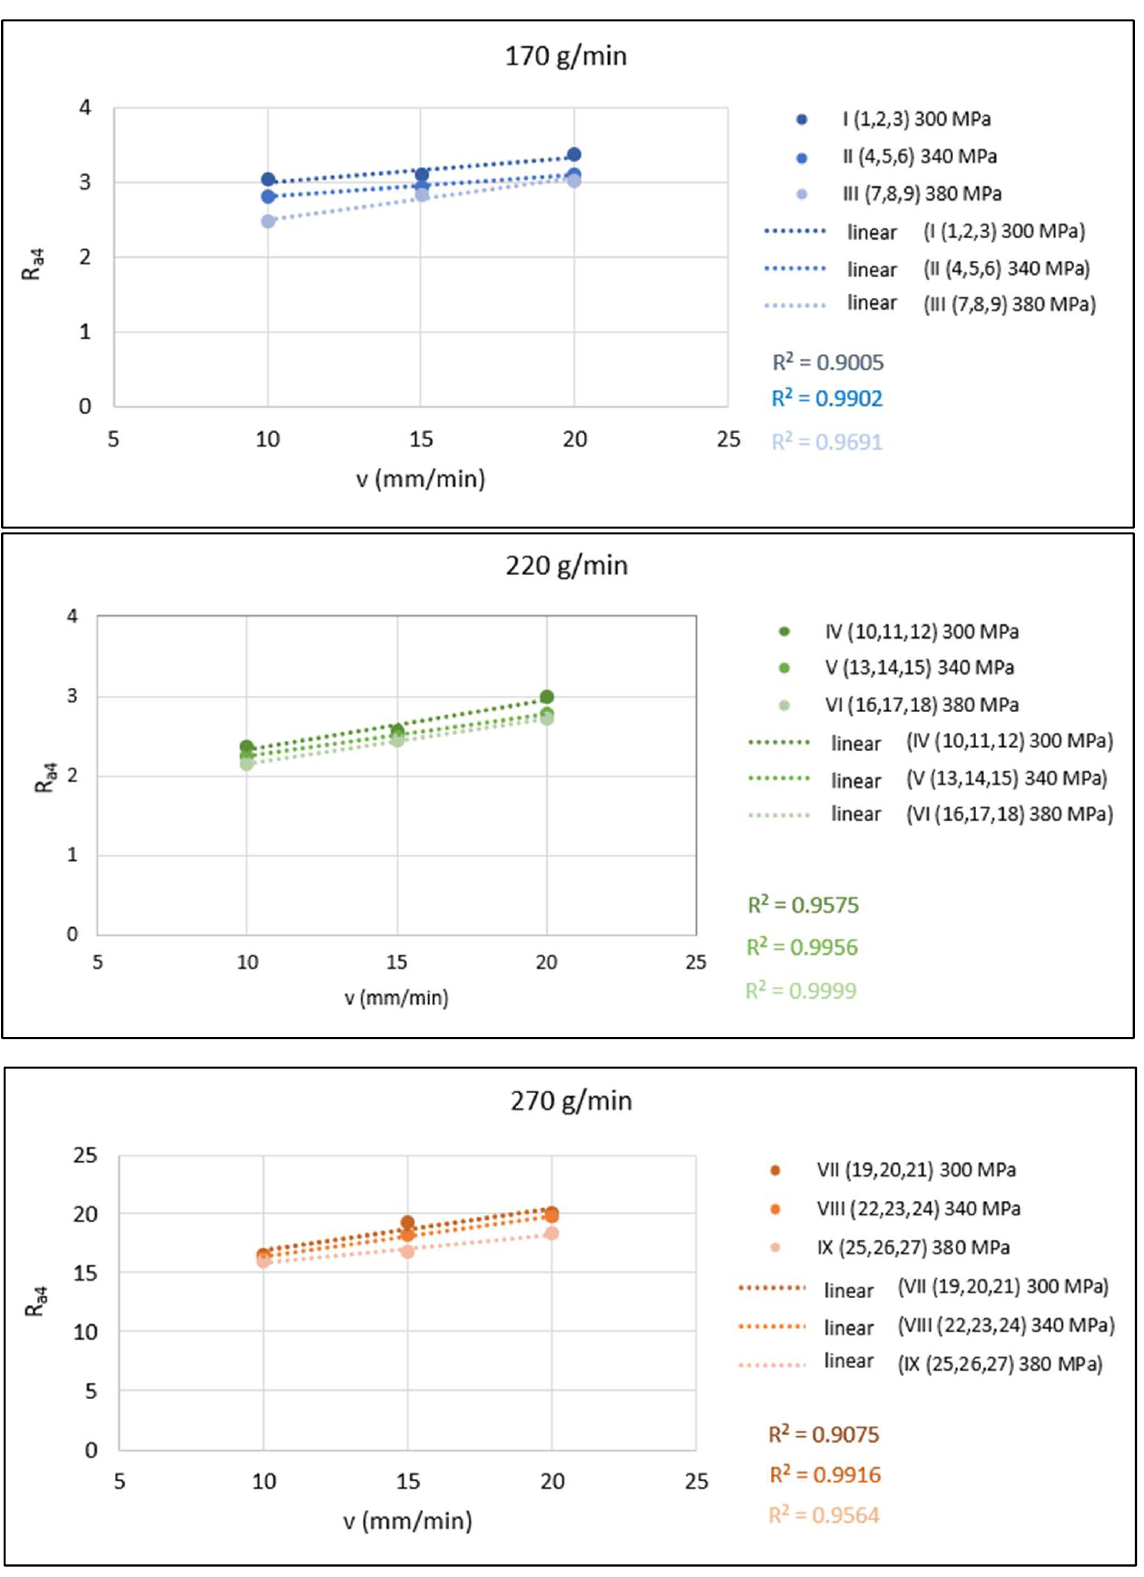
Figure 8. Graphical evaluation of 1-parametric dependencies of Ra 4 = f( v ) for m A = 170, 220 and 270 g/min.